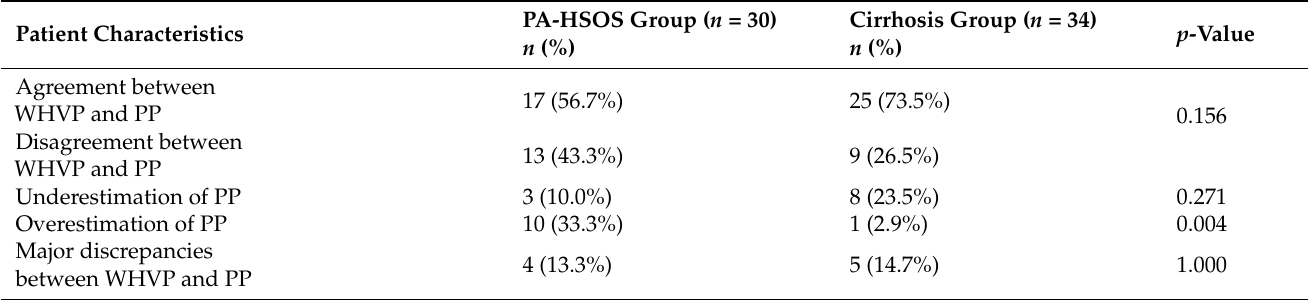
Table 3. Performance of WHVP in evaluating